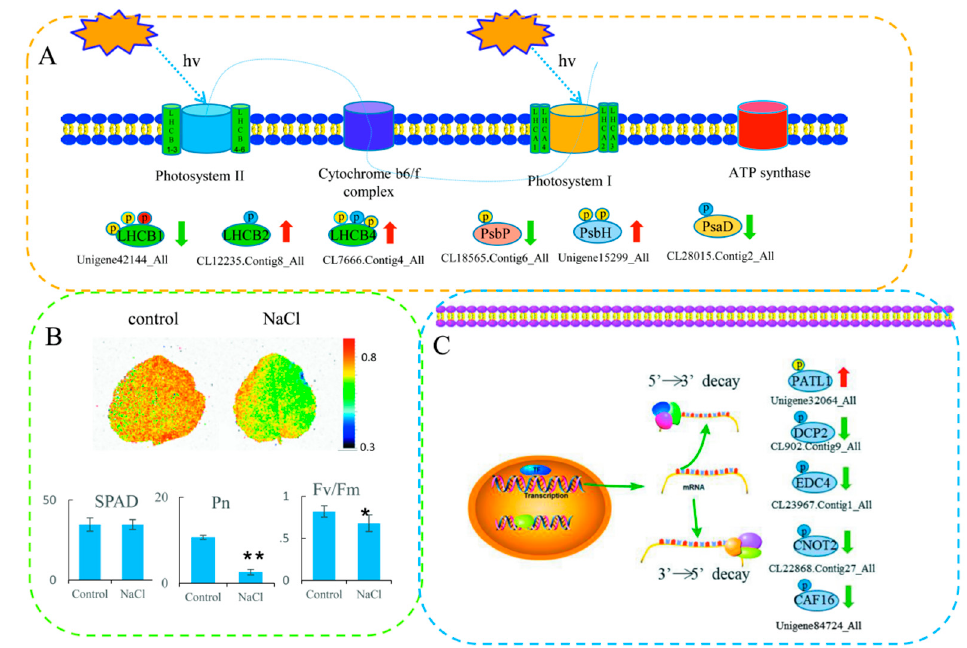
Figure 6. DPPs involved in photosynthesis and RNA degradation. ( A ) DPPs involved in photosynthesis. ( B ) The value of Fv/Fm, SPAD, Net photosynthetic rate (Pn) compared to respective controls in okra leaves after NaCl treatments. ( C ) DPPs involved in RNA degradation. The phosphorylated serine (S), threonine (T), and tyrosine (Y) residues are shown in blue, yellow, and red, respectively. LHCB1/2/4: light harvesting complex II chlorophyll a/b binding protein 1/2/4; PsbP: photosystem II oxygen-evolving enhancer protein 2; PsbH: photosystem II protein H; PsaD: PSI reaction center subunit II; PATL1: DNA topoisomerase 2-associated protein PAT1; DCP2: mRNA-decapping enzyme subunit 2; EDC4; enhancer of mRNA-decapping protein 4; CNOT2: CCR4-NOT transcription complex subunit 2; CAF16: CCR4-NOT complex subunit 16 .